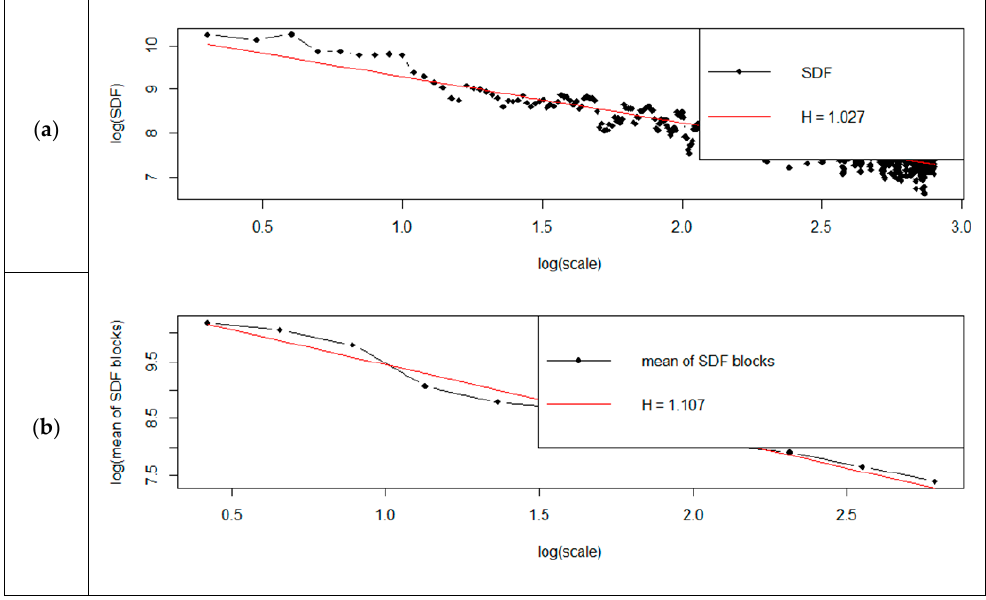
Figure 8. Spectral regression graph by multitaper method: ( a ) the standard method, ( b ) the smoothed method.